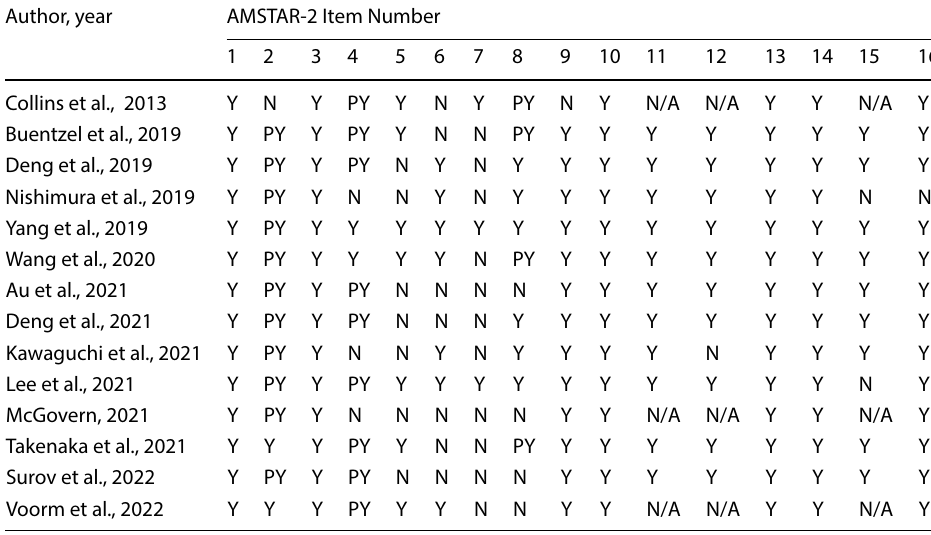
Table 2 AMSTAR-2